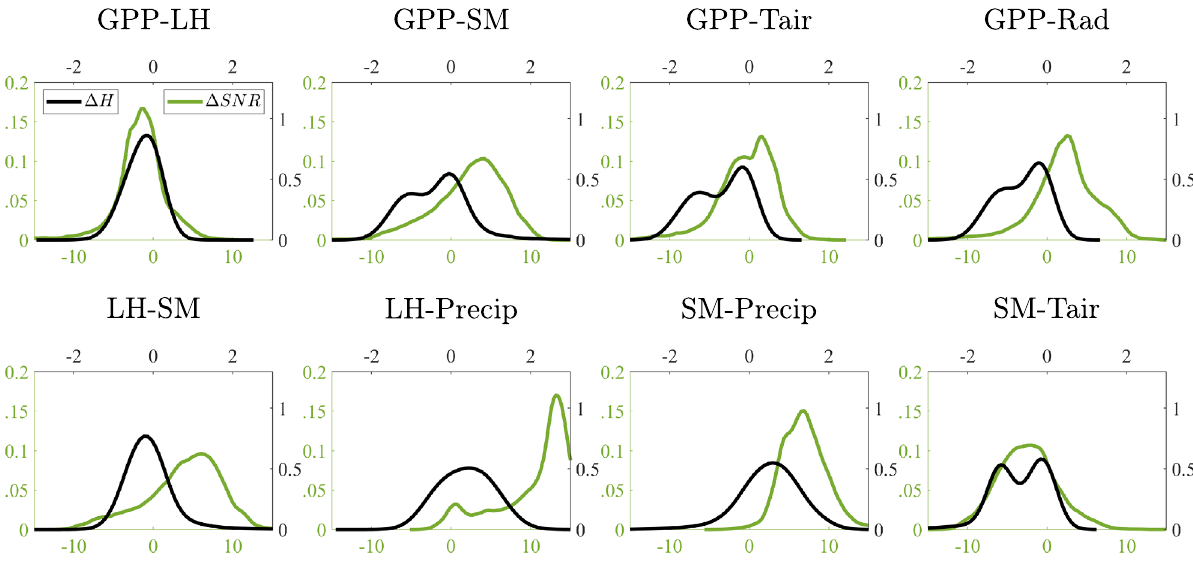
Figure 9. Densities of the differences in entropy, (cid:31) H (black lines), and signal-to-noise ratio, (cid:31) SNR[dB] (green lines) between the considered